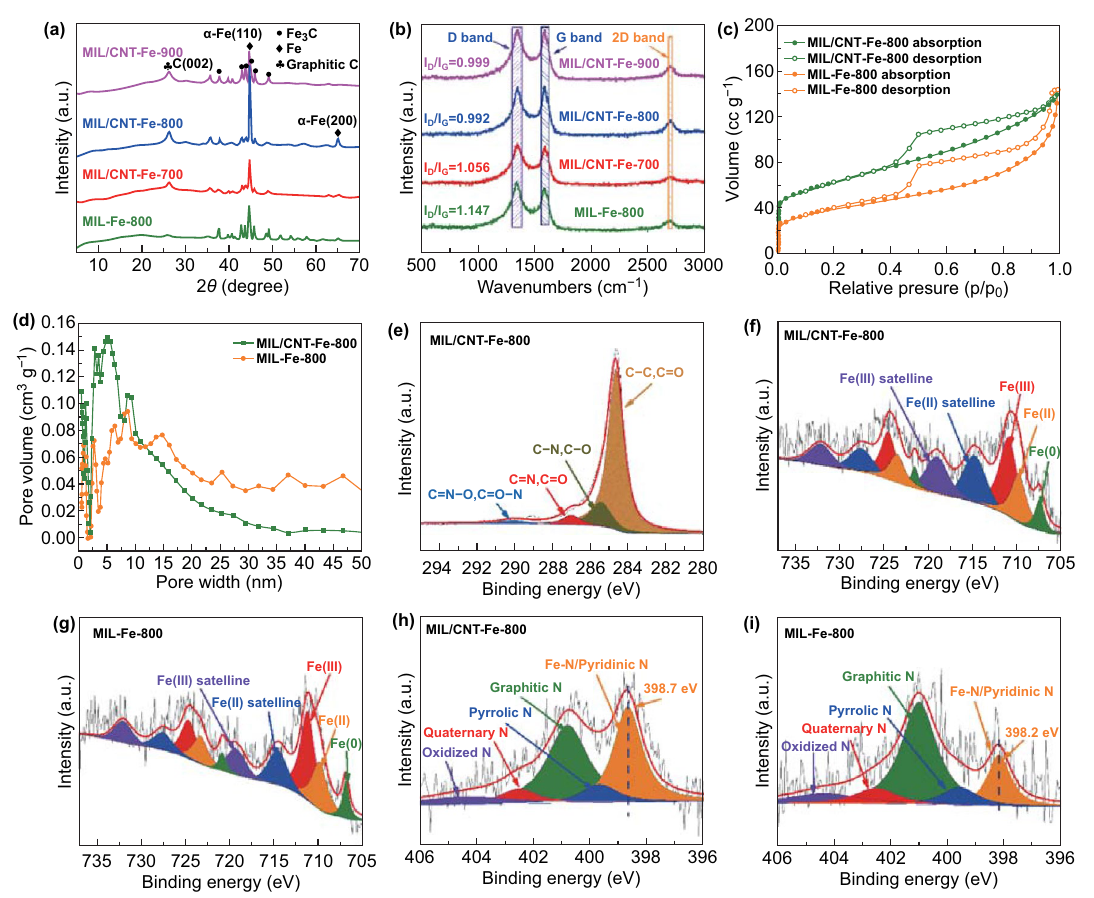
Fig. 3 a PXRD analysis of different samples. b Raman spectra of different samples. c N 2 adsorption–desorption isotherms of catalysts. d The pore size distributions of MIL/CNT–Fe-800 and MIL-Fe-800 calculated from the adsorption branch of the isotherms by the quenched solid den- sity functional theory (QSDFT) model for spherical pore type. High-resolution e C 1 s , f Fe 2 p , h N 1 s , XPS spectra of MIL/CNT–Fe-800. High- resolution g Fe 2 p and i N 1 s XPS spectra of MIL-Fe-800